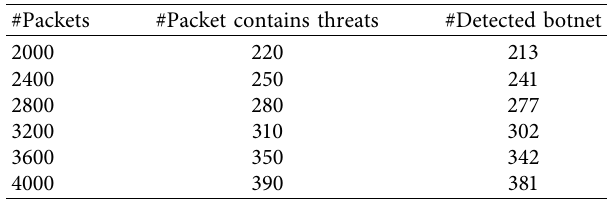
Figure 7: Botnet detection results. Table 3: Connections used in simulation from the dataset. Table 4: Results from executing the simulator for 6